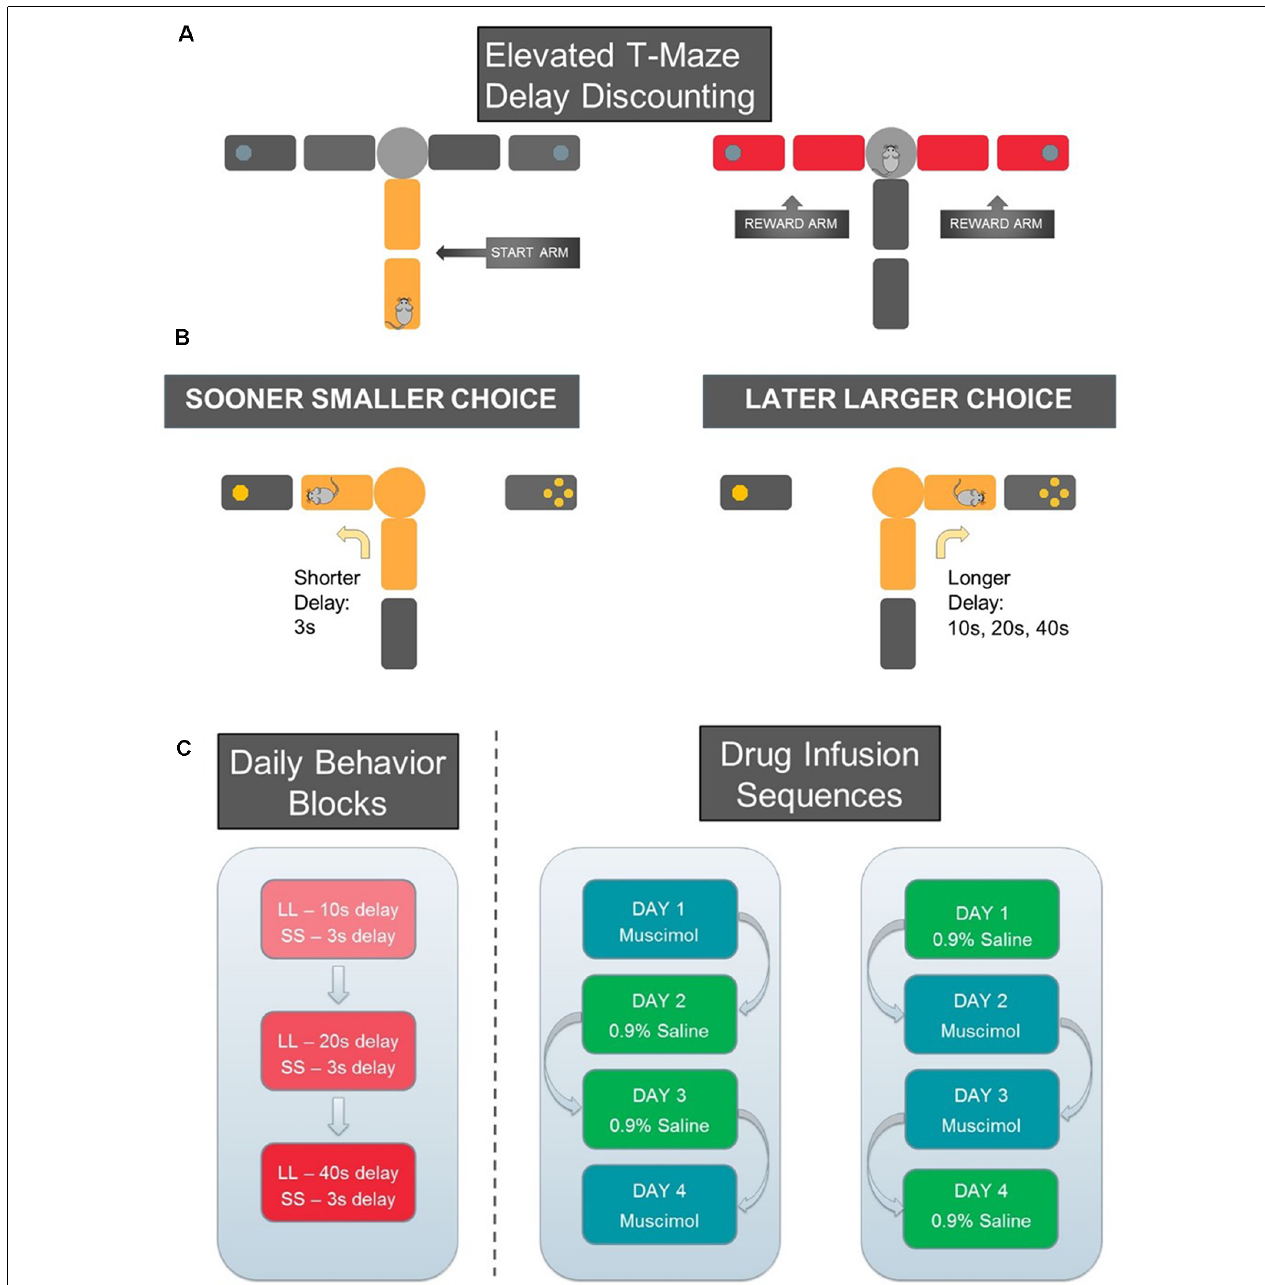
FIGURE 5 | Schematic of Delay-Discounting Task. (A) Reward arm (marked in yellow) and two start arms (marked in red) on the elevated T-maze. (B) Sooner smaller choice: the animal waited for 3 s to obtain one sugar pellet. Later larger choice: the animal waited for 10 s and obtained four sugar pellets. Once the animal entered one reward arm, the other reward and start arms were blocked by wooden barriers to confine the animal to the chosen arm for the entire delay period. (C) For each day of testing, three blocks of trials were offered, each associated with a different length of LL delay (10 s, 20 s, or 40 s). The SS delay remained constant (3 s). The blocks were separated by an inter-block interval of 5 min. Drug infusion sequences follow an ABBA pattern. On day 1 and day 4, a certain animal would receive one type of infusion (0.9% saline or muscimol), and day 2 and day 3 of the alternative type of